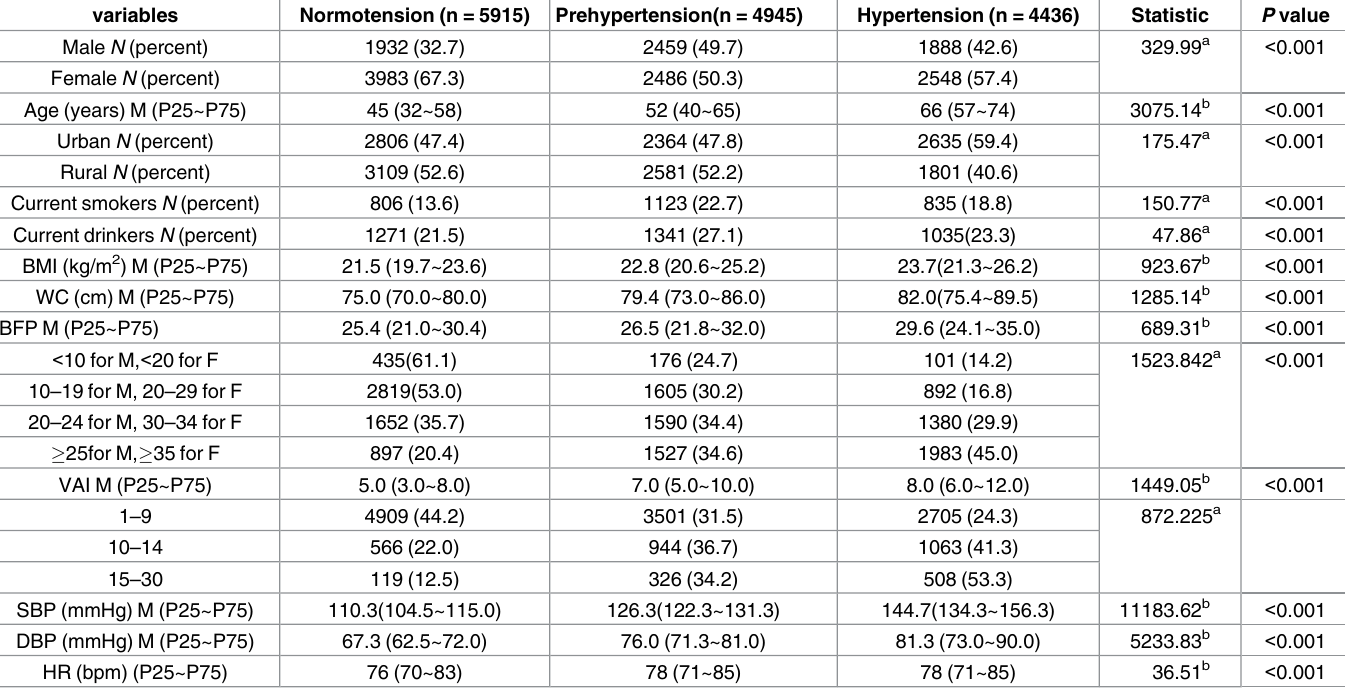
Table 1. Characteristics of participants stratified by